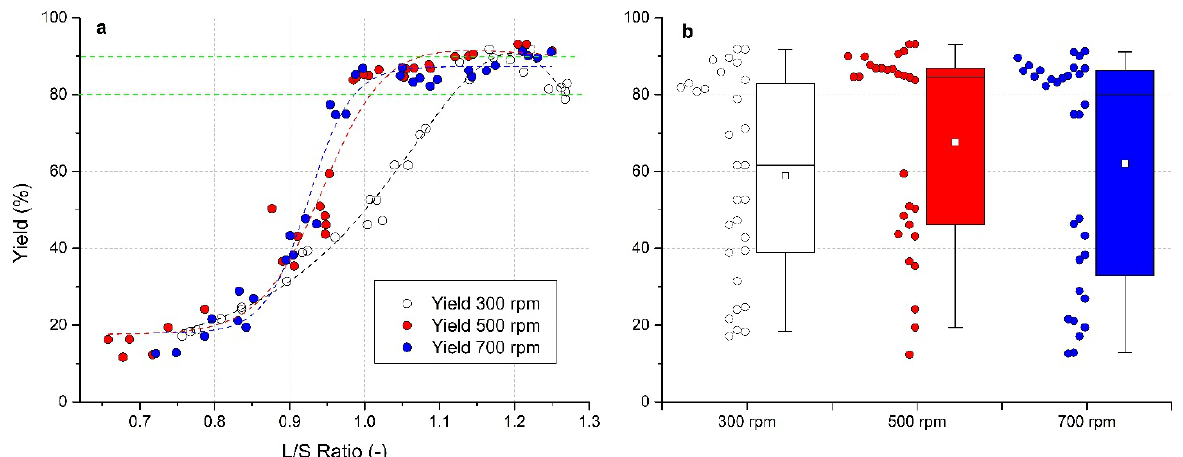
Figure 5. Evaluation of yield fraction (0.4–3 mm) for impeller speeds of 300, 500, and 700 rpm: ( a ) effect of the L/S ratio on yield fraction, green lines indicate yield interval from 80 to 90%, ( b ) box charts of yield fraction for different impeller speeds.